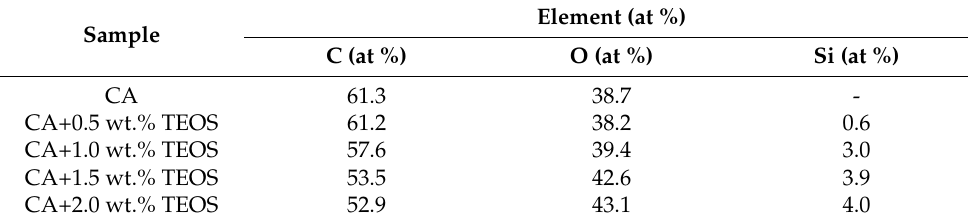
Table 2. Atomic concentrations at the cellulose acetate/silica films surfaces.